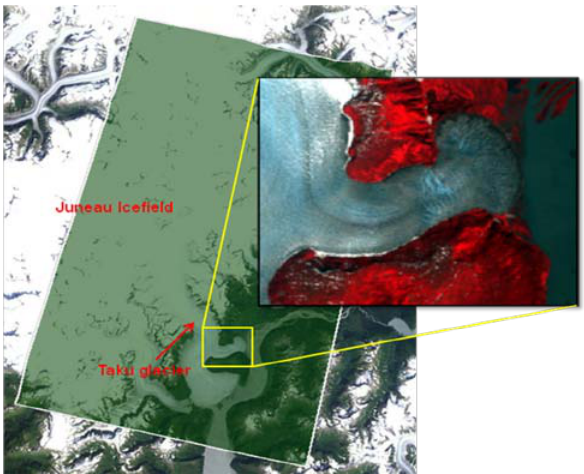
Figure 1. Ground coverage of geo-coded SAR data plotted on an optical image of the scene. The optical data in right side is cut from the Landsat TM data. (Underlying optical image ©2014 Google